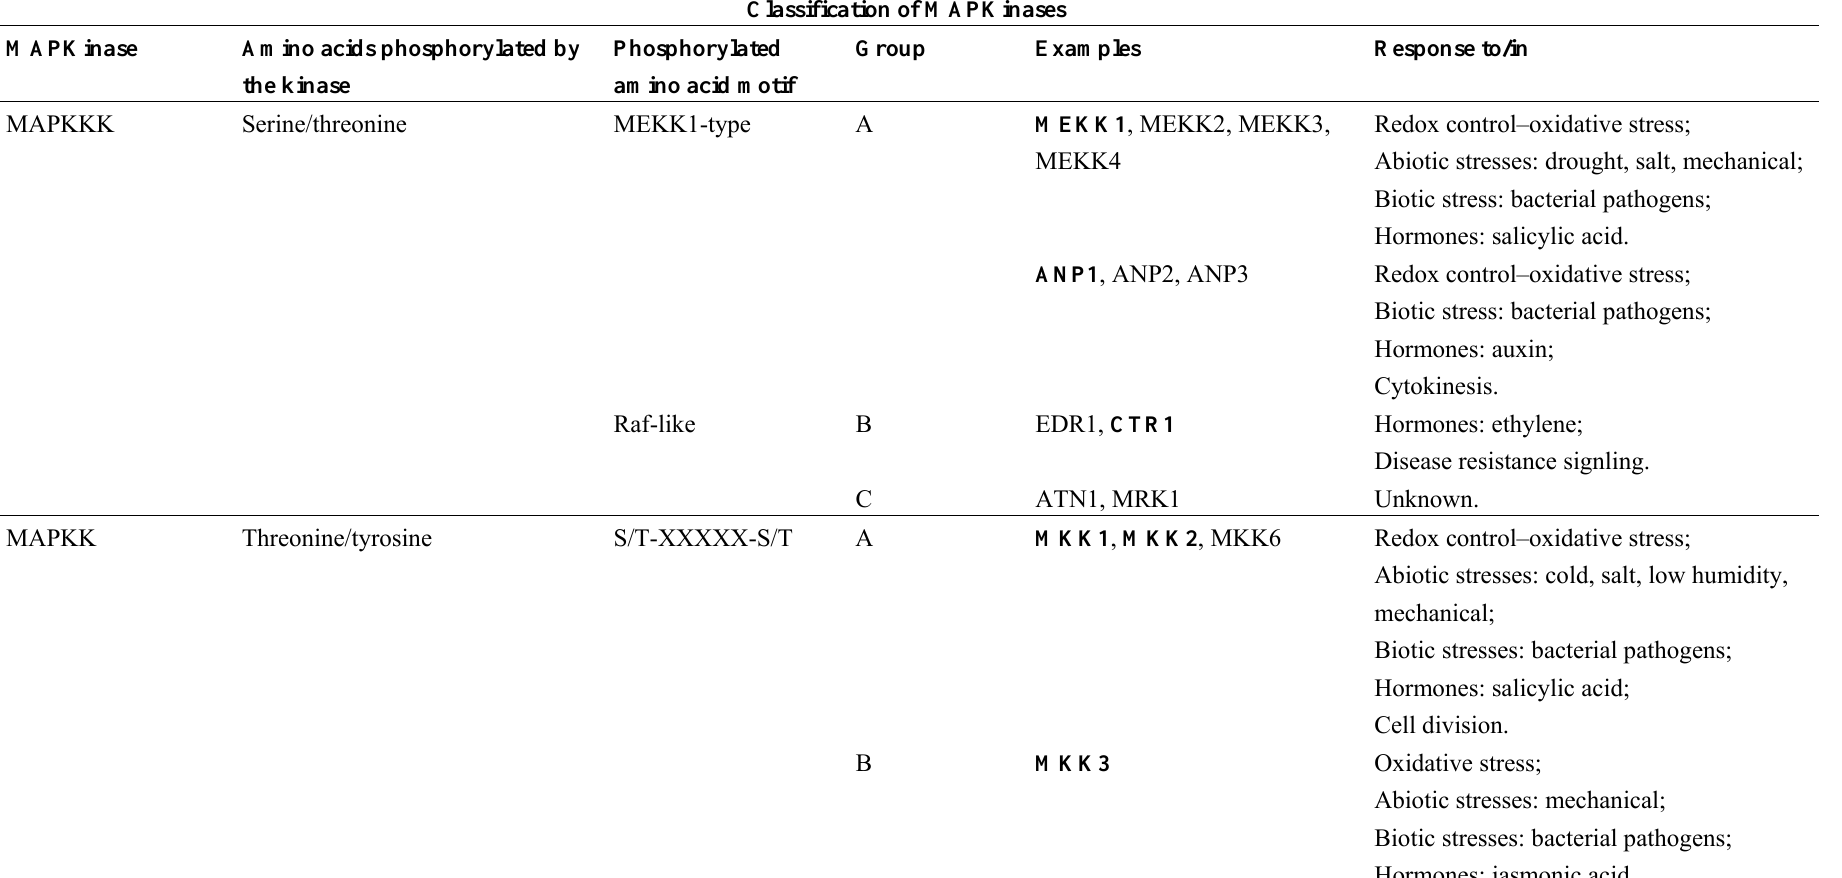
Table 1. Classification of mitogen-activated protein (MAP) Kinases. In the first and second column, the different MAPKinase modules and the amino acid sequences phosphorylated by them are presented. Then MAPKKKs, MAPKKs and MAPKs are classified according to their phosphorylated amino acid sequence and placed in groups A to D based on sequence alignment. In the final two columns, examples of MAPKinases belonging to each group as well as the plant responses, in which they are involved, are provided. MAPkinases indicated in bold are discussed in this